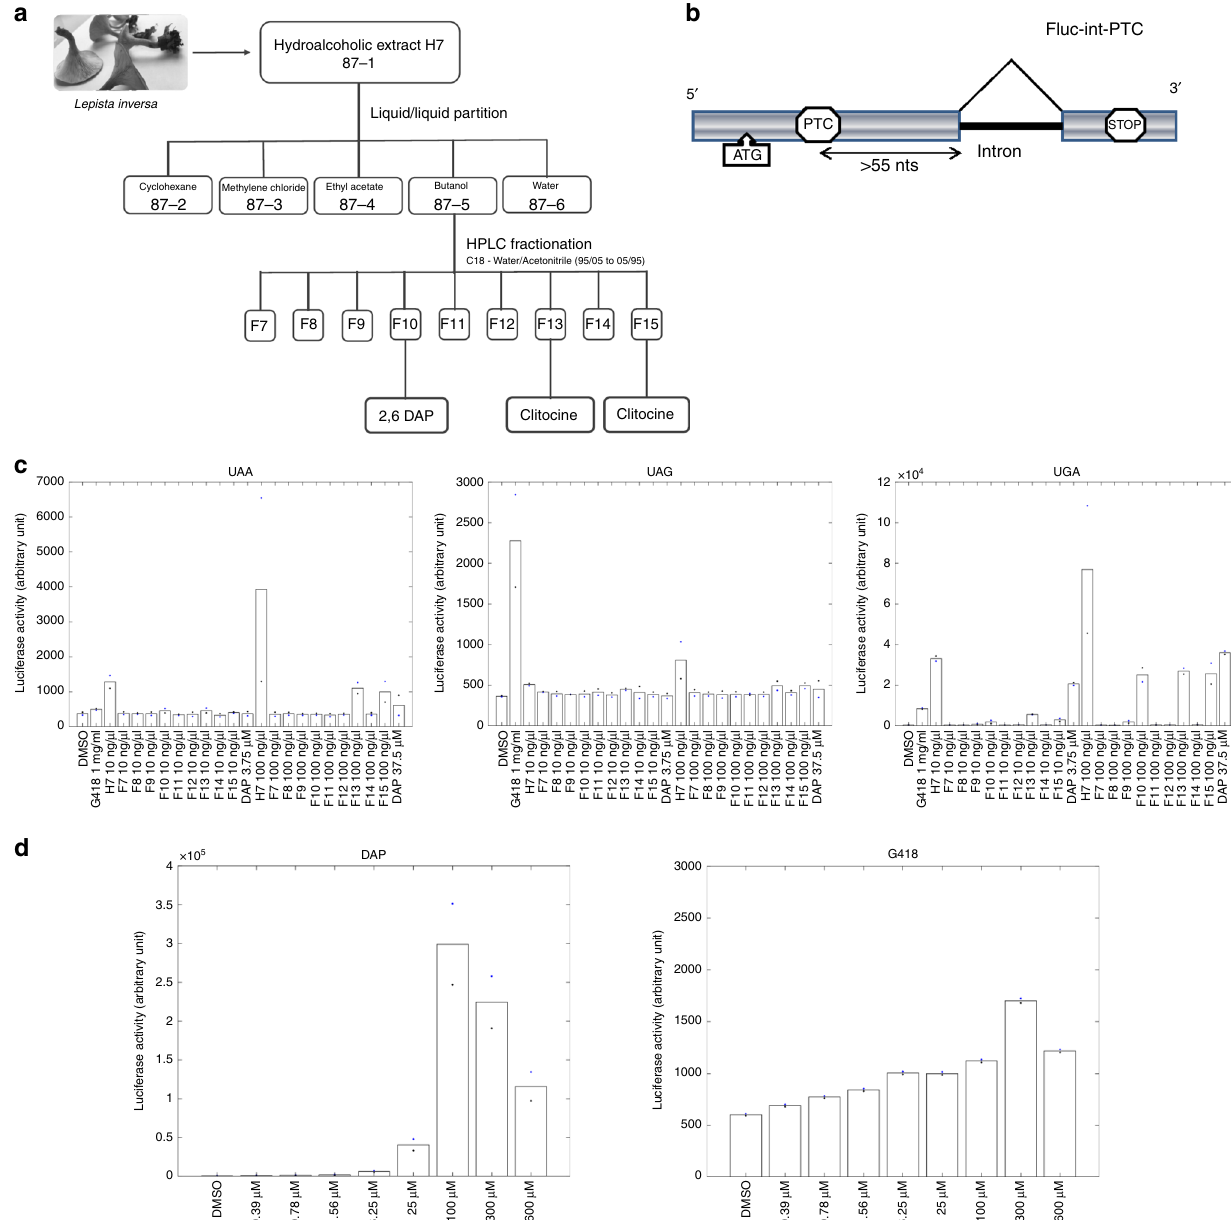
Fig. 1 Identi fi cation of DAP as an ef fi cient and exclusive corrector of UGA nonsense mutations. a Fractionation pathway of H7 L. inversa extract, starting from fraction F87-1. b Schematic representation of the fi re fl y luciferase construct used to measure readthrough activity. HeLa cells were transfected with an expression vector carrying a fi re fl y luciferase (Fluc) gene consisting of the open-reading frame encoding fi re fl y luciferase interrupted by an intron and a nonsense codon at position 109. c Luciferase activity in HeLa cells transfected with the construct described in b carrying a UGA, UAA, or UAG PTC and incubated with DMSO, H7 extract, one of various H7 fractions, or DAP. The value of each luciferase measurement is presented in the Source Data File. d Readthrough activity on the construct described in b as a function of the G418 or DAP dose. The value of each luciferase measurement is presented in the Source Data File. All data shown in c , d are representative of two independent experiments. Source data are provided as a Source Data fi